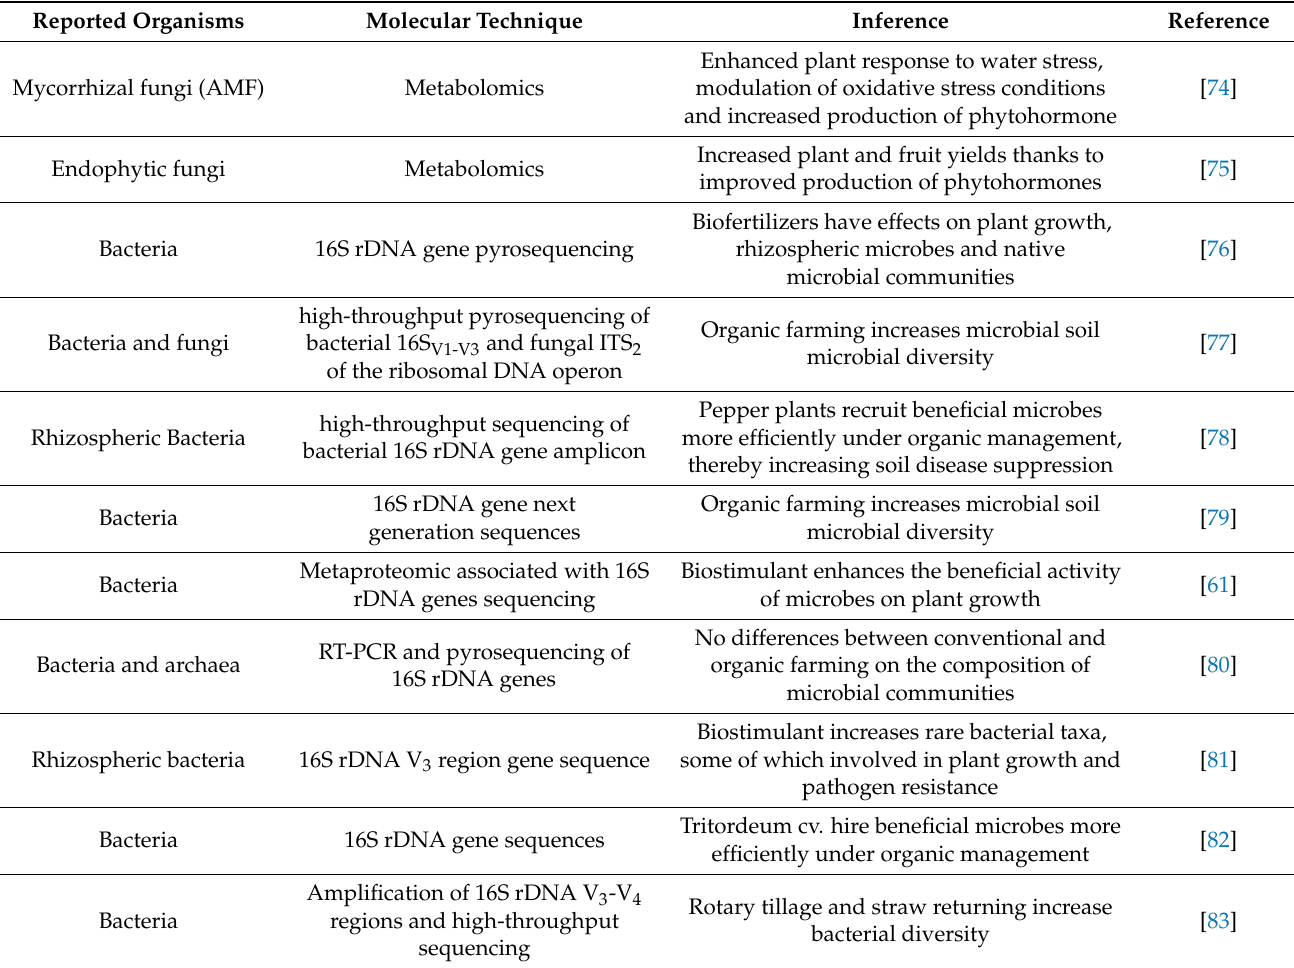
Table 1. -Omics approaches applied to soil microbial diversity